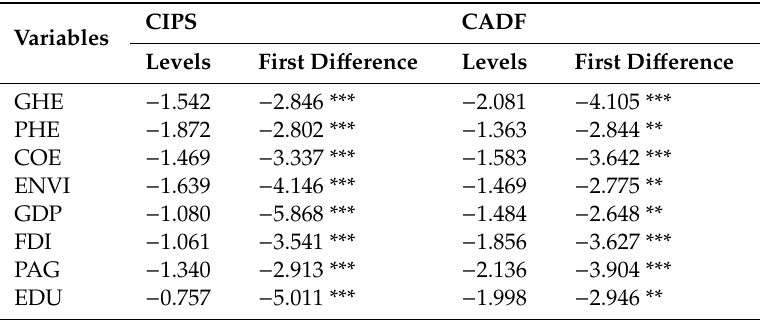
Table 4. Second generation unit root tests